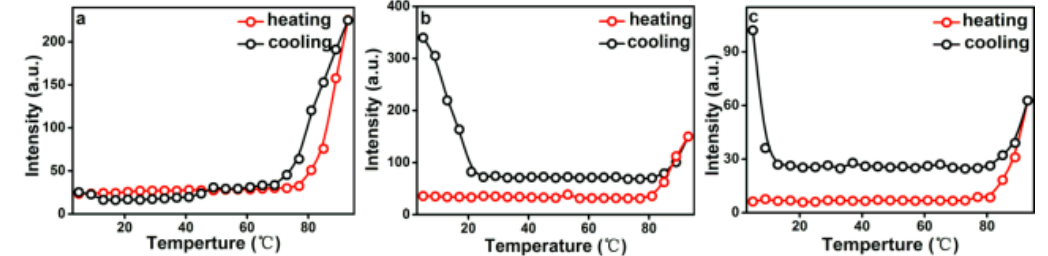
Figure 7. Temperature dependence of I 490 in a heating and cooling run with various PEG-acrylic rosin polymer concentration solutions ( a : 2.0 g L − 1 , b : 0.5 g L − 1 and c : 0.01 g L − 1 ).